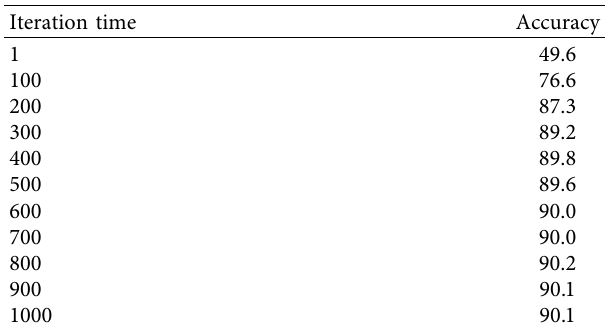
Table 5: Influence of iteration time on classification accuracy.